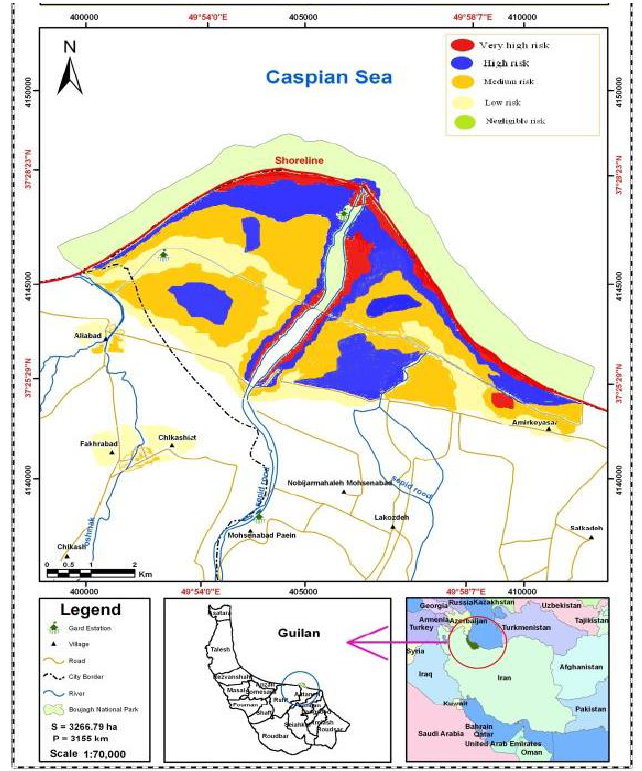
Fig. 7: The performed environmental risk zoning for Boujagh Wetland area